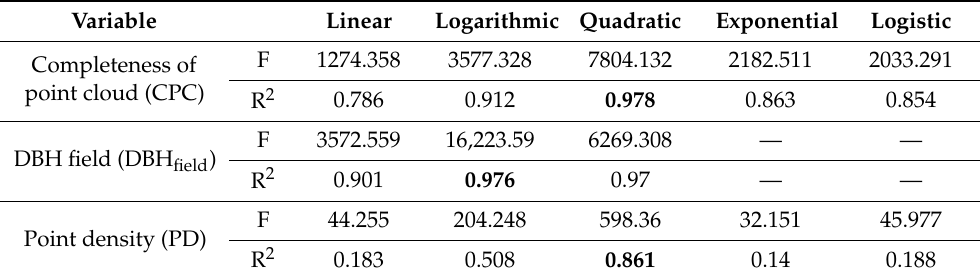
Table 1. Curve fitting for the marginal response of the DBH measurement error ( ∆ DBH) obtained with the random forest model. The table shows the F value and R 2 value for the